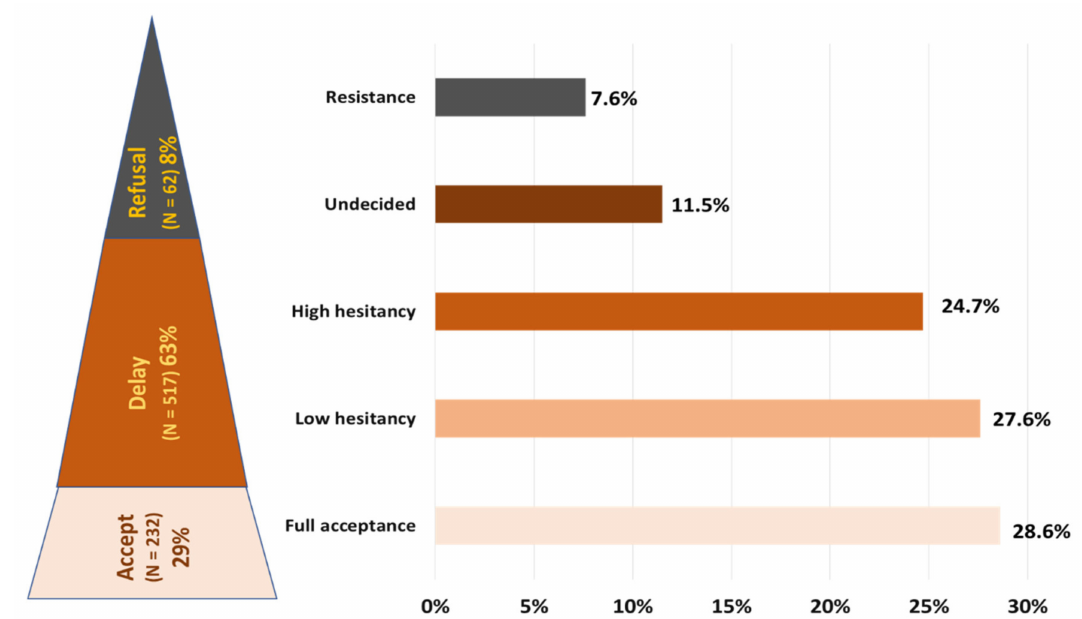
Figure 3. COVID-19 vaccine acceptance spectrum among health